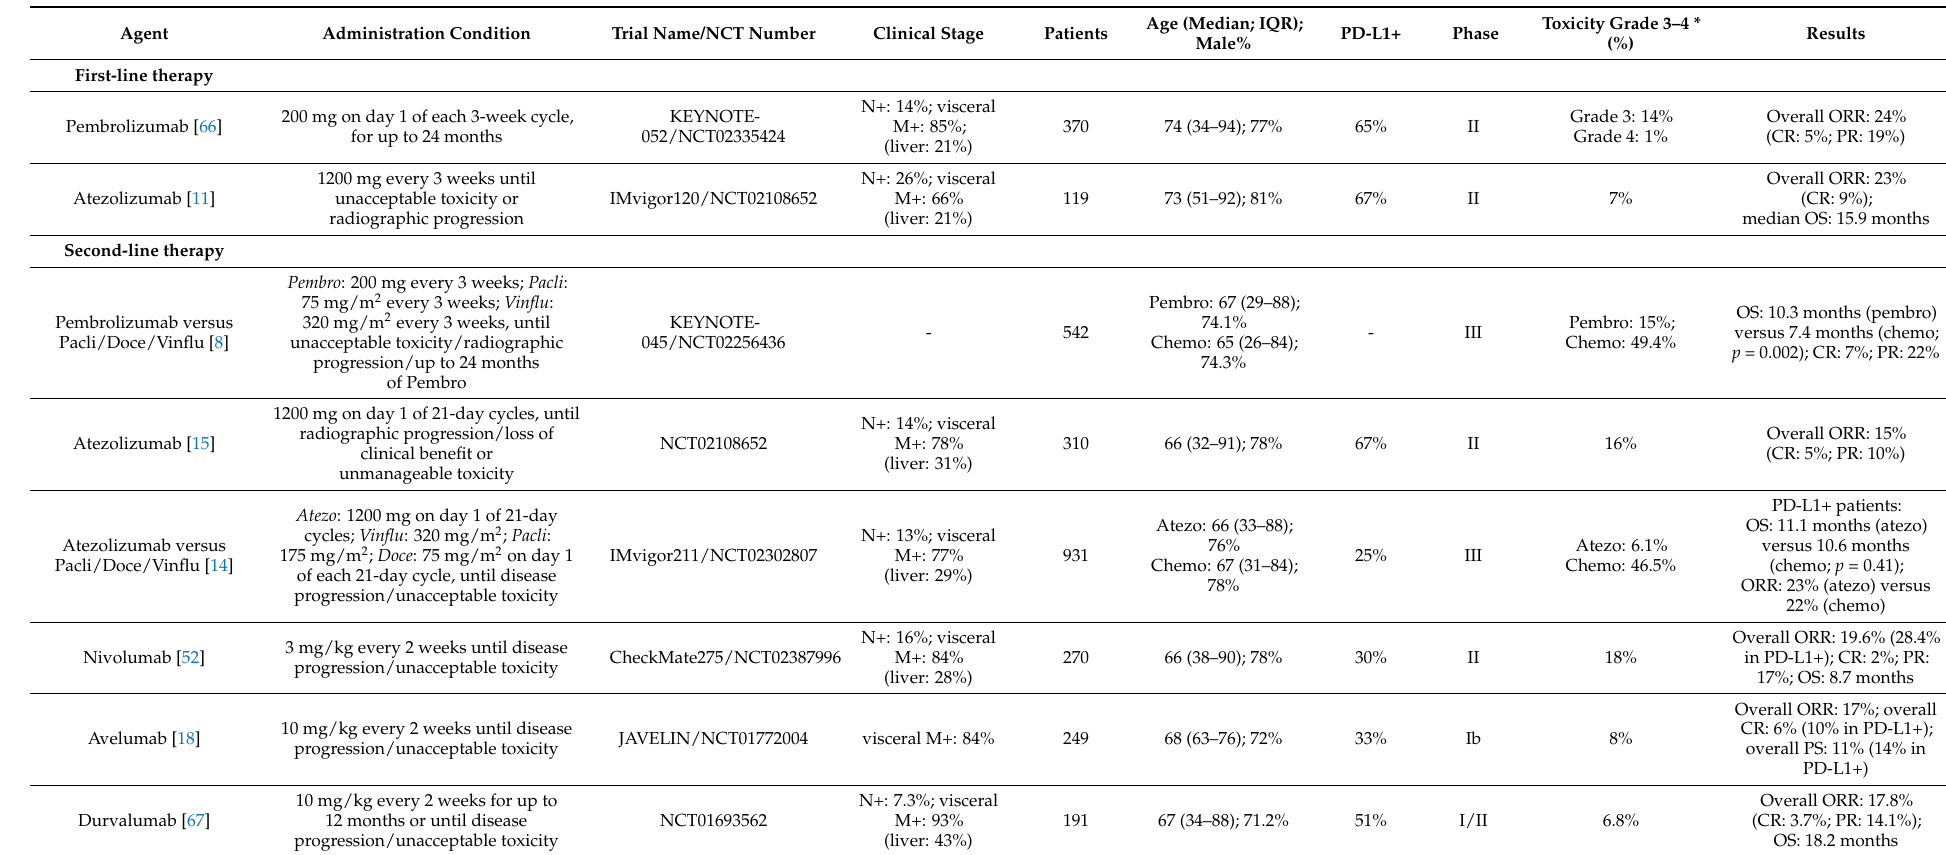
Table 2. Immune checkpoint inhibitors for the treatment of metastatic cisplatin-unfit bladder